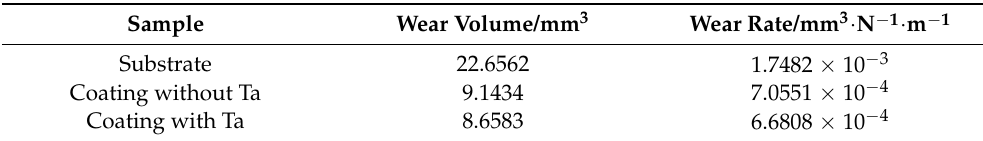
Figure 11. Worn profiles of the substrate and the coatings subject to friction in the alkaline environment. Table 7. Wear volumes and wear rates of the substrate and the coatings subject to friction in the alkaline